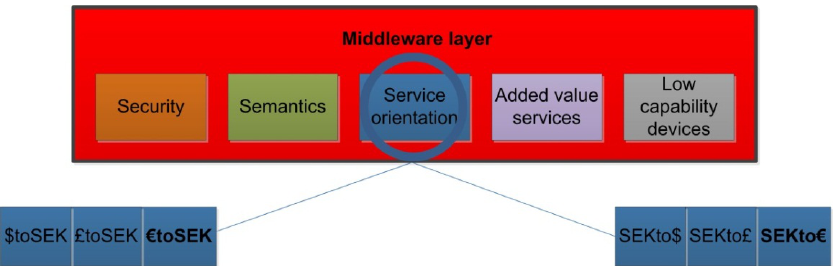
Figure 2. Inner view of expected middleware